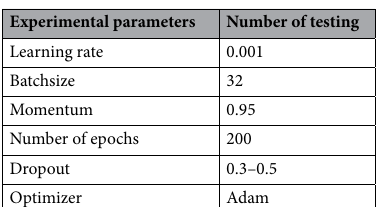
Table 3. Setting of super parameters of neural network during experiment.